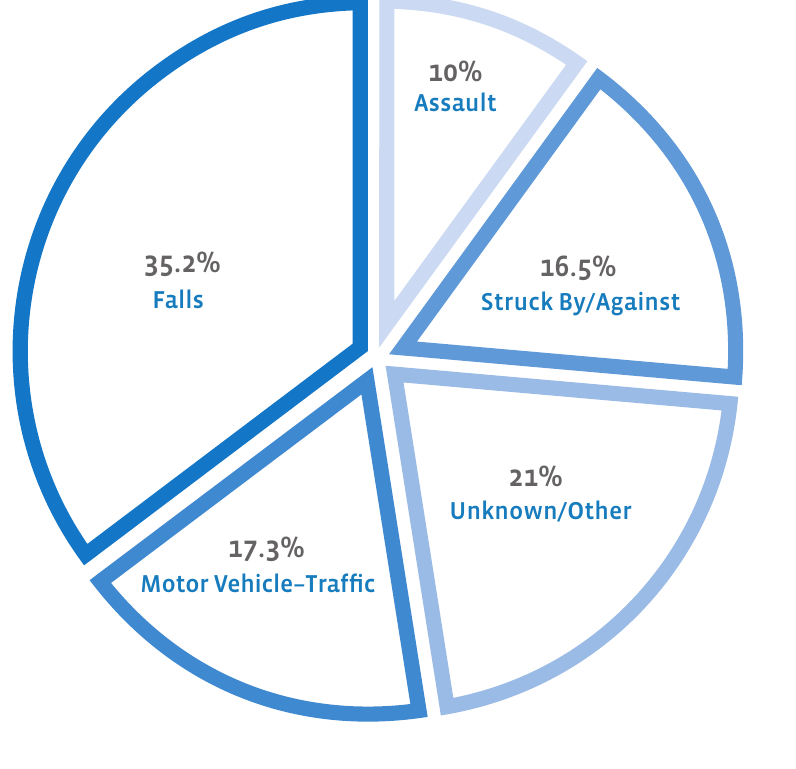
FIGURE 5: Estimated Average Percentage of Annual Traumatic Brain Injury-Combined Emergency Department Visits, Hospitalizations, and Deaths, by External Cause, United States,